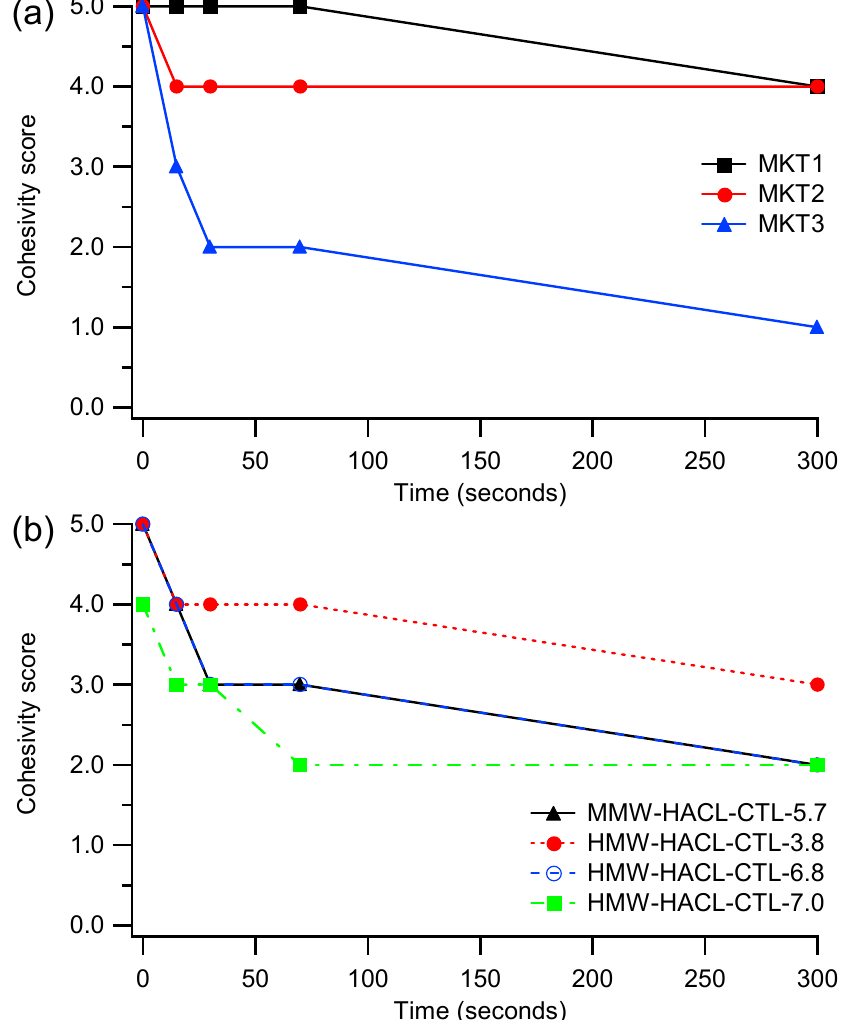
Figure 2. Cohesivity score in deionized water at 0, 30, 60 and 300 s of ( a ) commercial samples and ( b ) HACL-CTL fillers. Lines are added only to guide the eyes. Data regarding samples MMW- HACL-CTL-5.7 and HMW-HACL-CTL-6.8 are superimposed. Cohesivity scores are the following: 1: fully dispersed; 2: mostly dispersed; 3: partially dispersed, partially cohesive; 4: mostly cohesive; 5: fully cohesive.